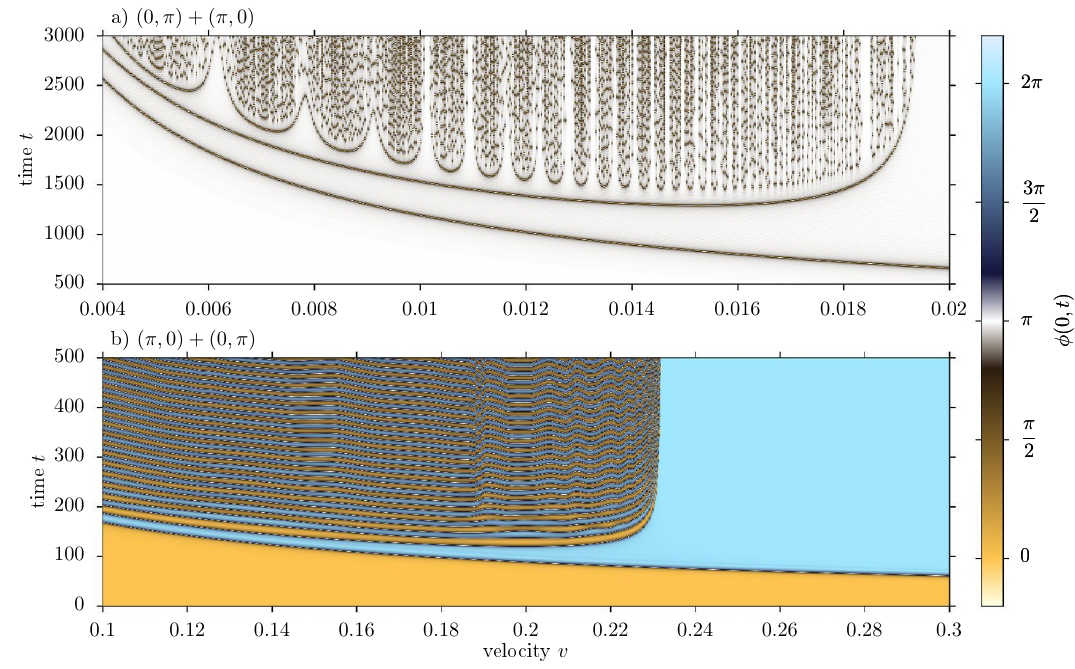
Figure 30 . Collision of small antikinks and kinks for critical value (cid:15) = (cid:15) cr for alignments (0 , π ) + ( π, 0) (a) and ( π, 0) + (0 , π )